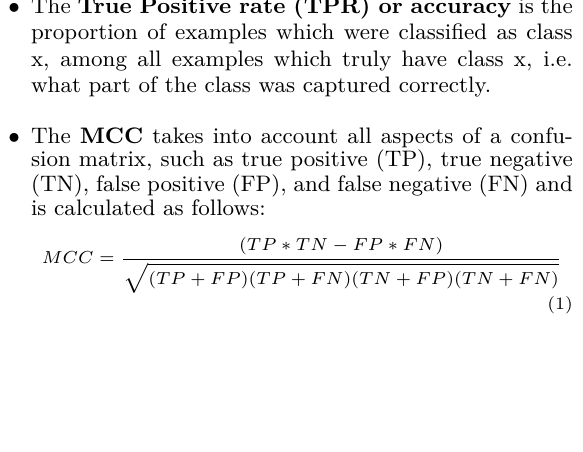
sistency for novice rowers, the results in Section 5.3 indicate that the overall technique of the novice rowers becomes less similar to the experienced rowers at higher stroke rates. We speculate that it becomes more difficult to maintain correct technique at higher stroke